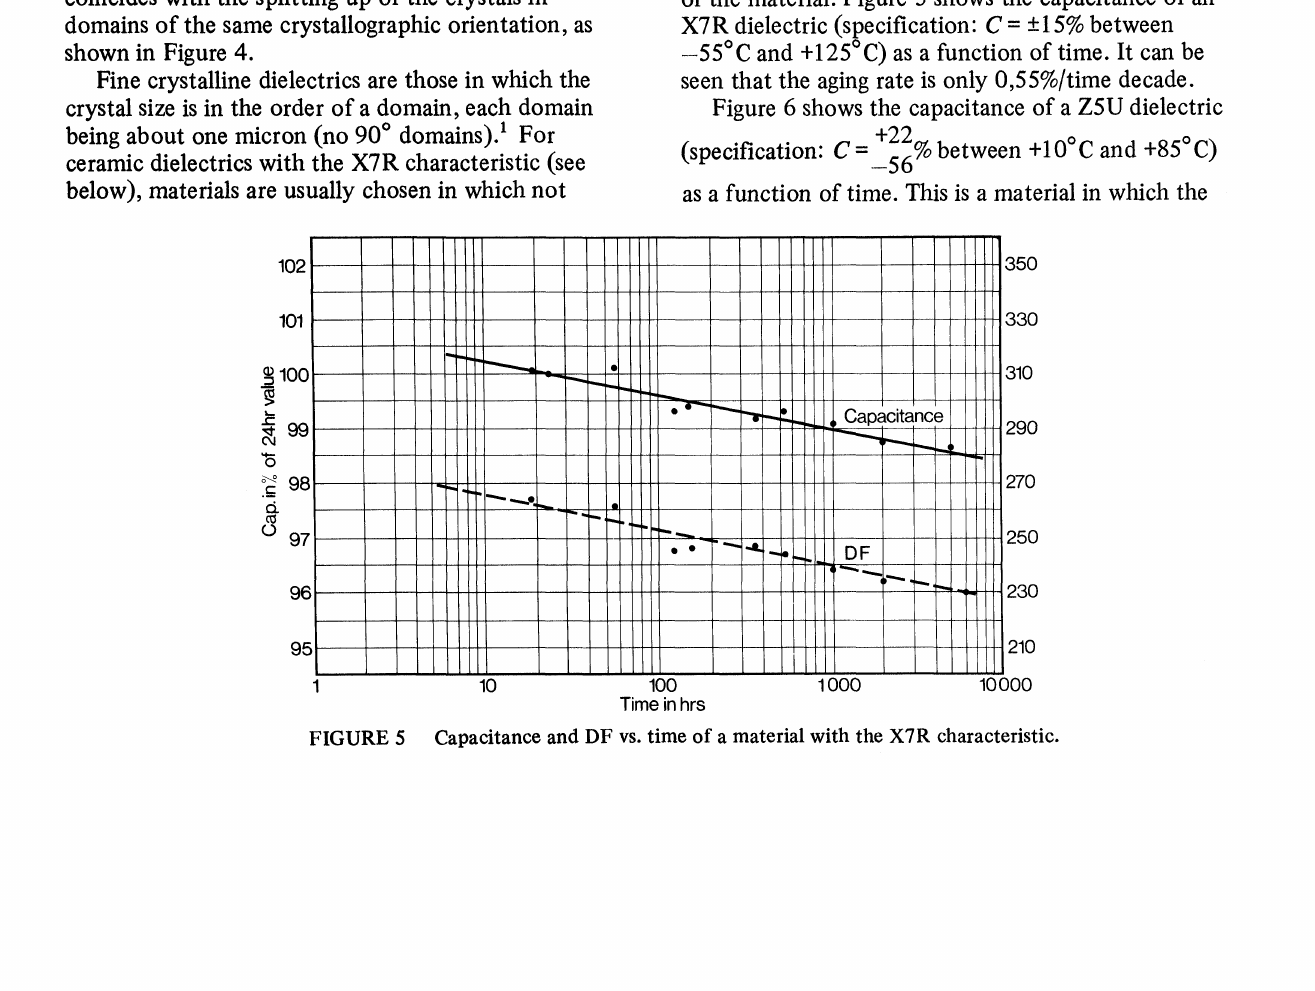
FIGURE 5 Capacitance and DF vs. time of a material with the X7R